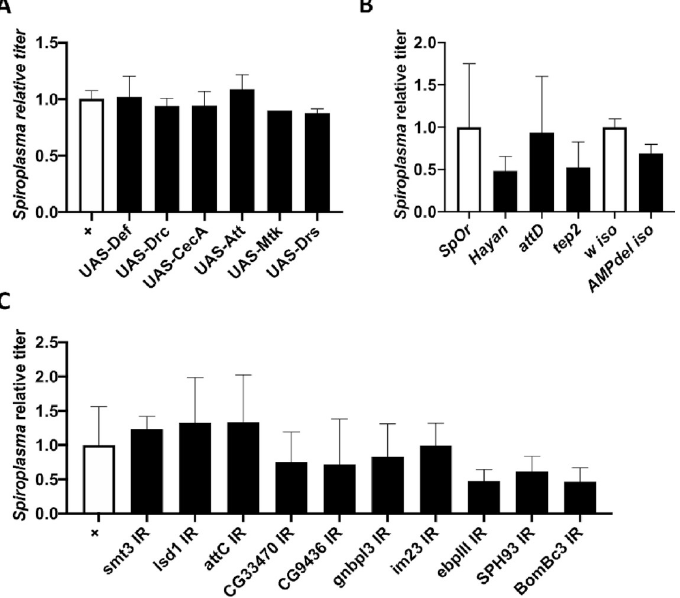
Fig 3. Targeted genetic screening of candidate proteins. (A-C) Quantification of Spiroplasma titer in two weeks old flies in various genetic backgounds. Titer is expressed as the fold-change over the appropriate control line. All graphs represent the mean +/- standard deviation of a pool of at least 2 independent experiments with 3 biological replicates each. (A) Control flies ( Act5C-GAL4 driver crossed w 1118 , white bars) are compared to flies overexpressing a single antimicrobial peptide gene driven by the ubiquitous Act5C-GAL4 driver (black bars). Titer is expressed as the fold- change over control. (B) Quantification of Spiroplasma titer in wild-type flies ( Oregon R , white bar) and hayan , attD and tep2 null mutants (black). Spiroplasma titer in AMP10 iso flies were compared to that of their isogenic wild-type counterpart ( w 1118 iso, white bar). (C) Quantification of the impact of RNAi-mediated knockdown on Spiroplasma titer with the Act5C-GAL4 driver. Titer is expressed as the fold-change over the control ( Act5C-GAL4 driver crossed to w 1118